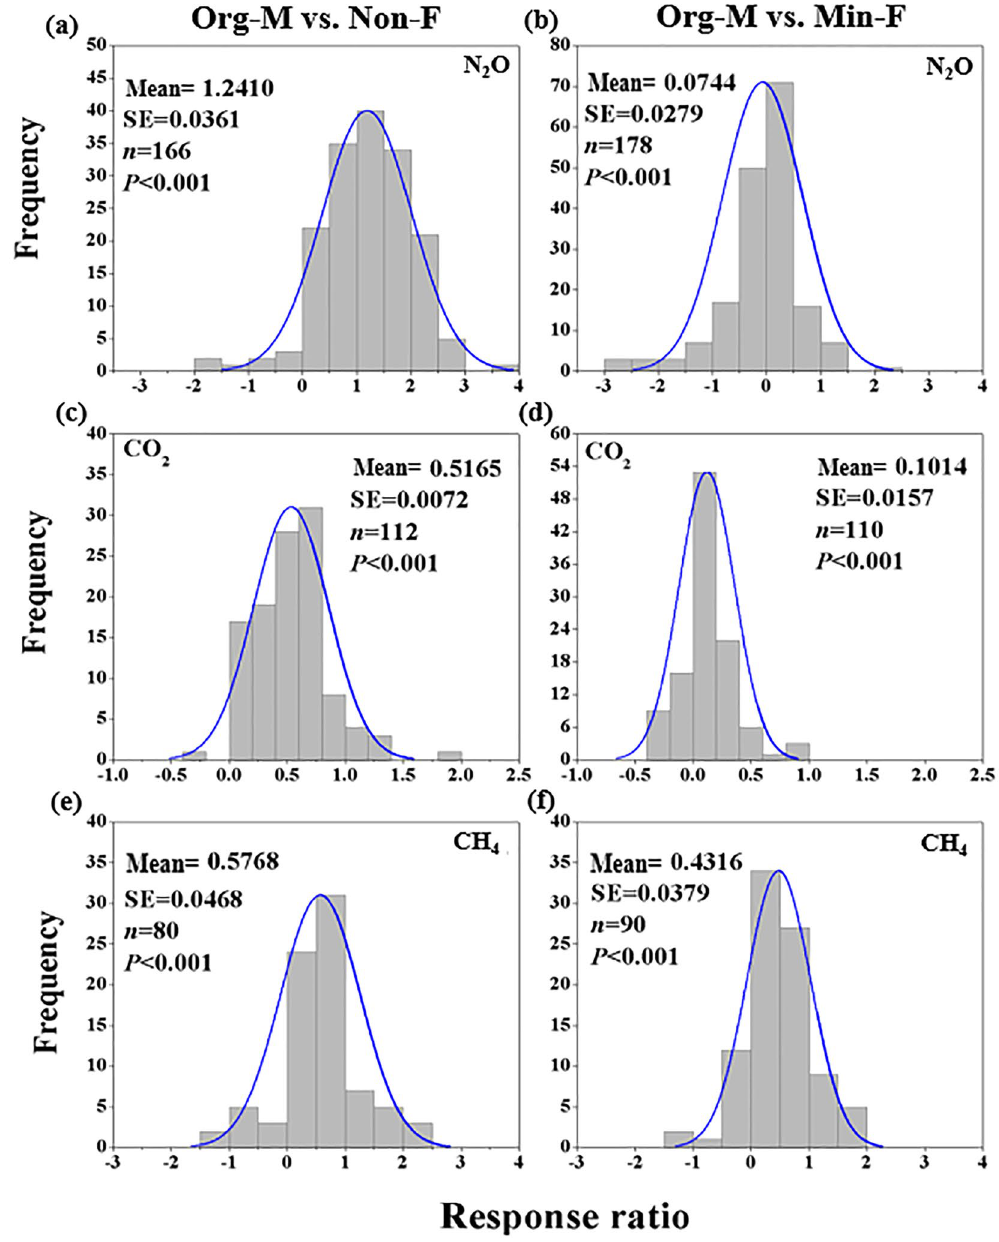
Figure 1. Frequency distributions of response ratios (ln RR ) for N 2 O ( a , b ), CO 2 , ( c , d ) and CH 4 ( e , f ) responses to Org-M in comparison with the control group Non-F and Min-F, respectively. The solid curve is a Gaussian distribution fitted to frequency